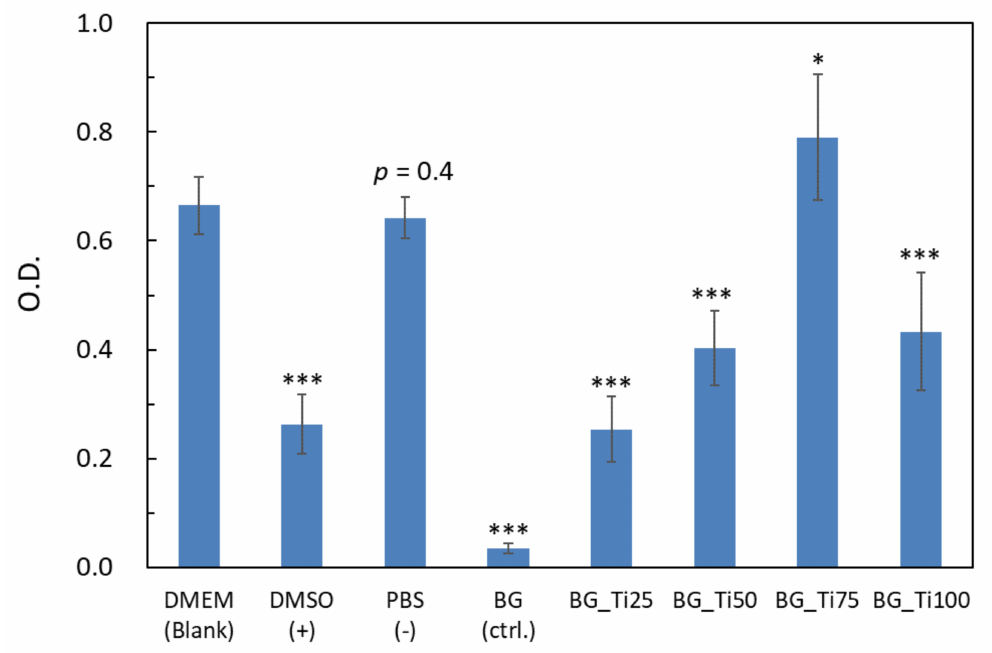
Figure 6. The cell toxicity test of MG63 cells incubating for 1 day in DMEM, DMSO, PBS, the extraction of bioglass, and the extractions of bioceramics composed of silica and titanium oxide with various concentrations of titanium oxide. (* means p value <0.05, ** means p value <0.01, and *** means p value <